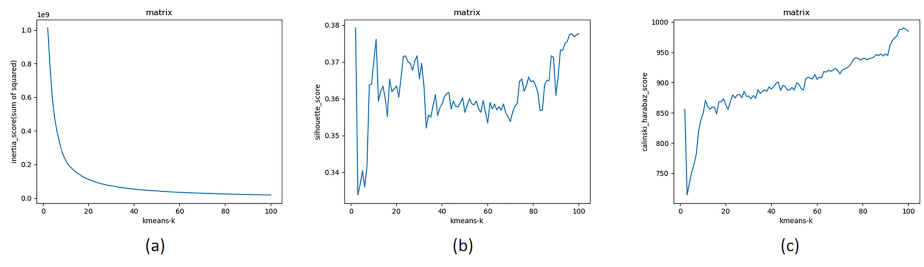
Figure 7. The results of the indicators i_s ( a ), s_s ( b ), and ch_s ( c ) for k-means